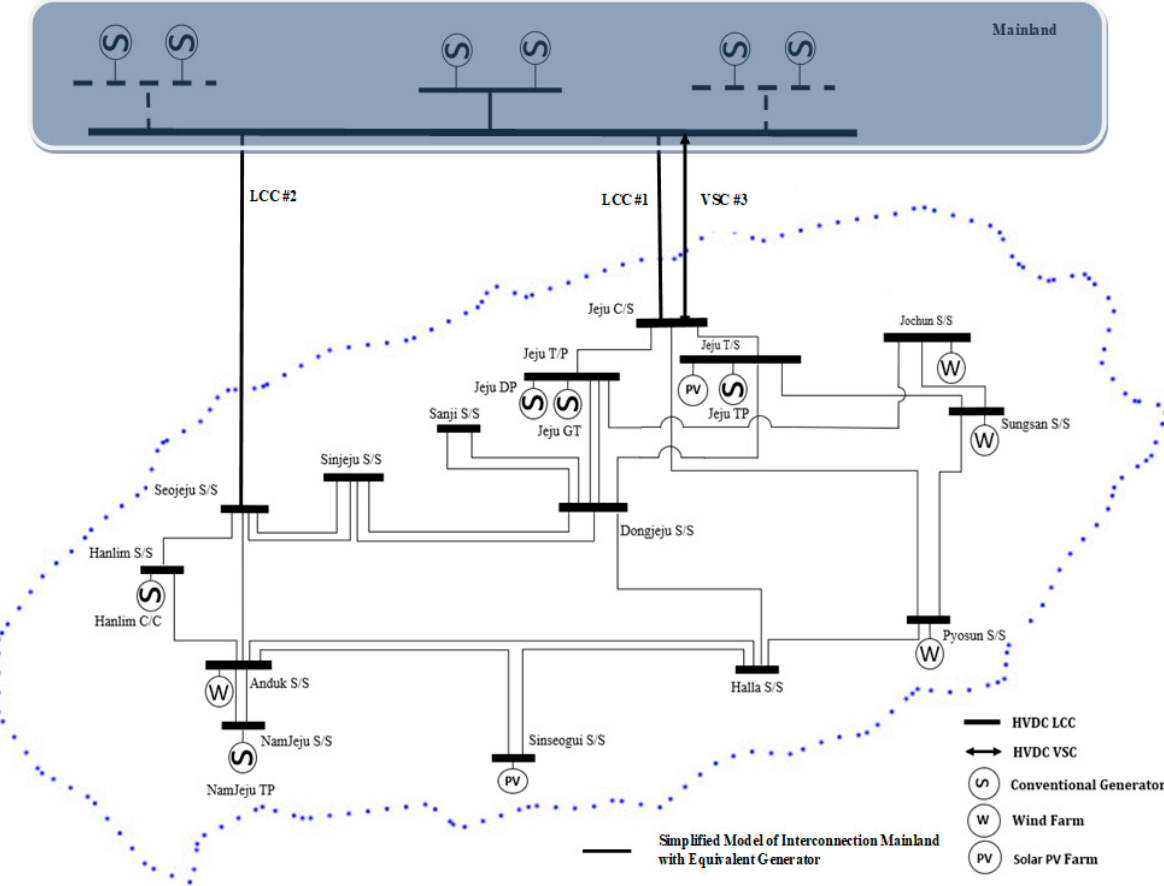
Figure 13. Jeju Island power system with HVDC configuration.